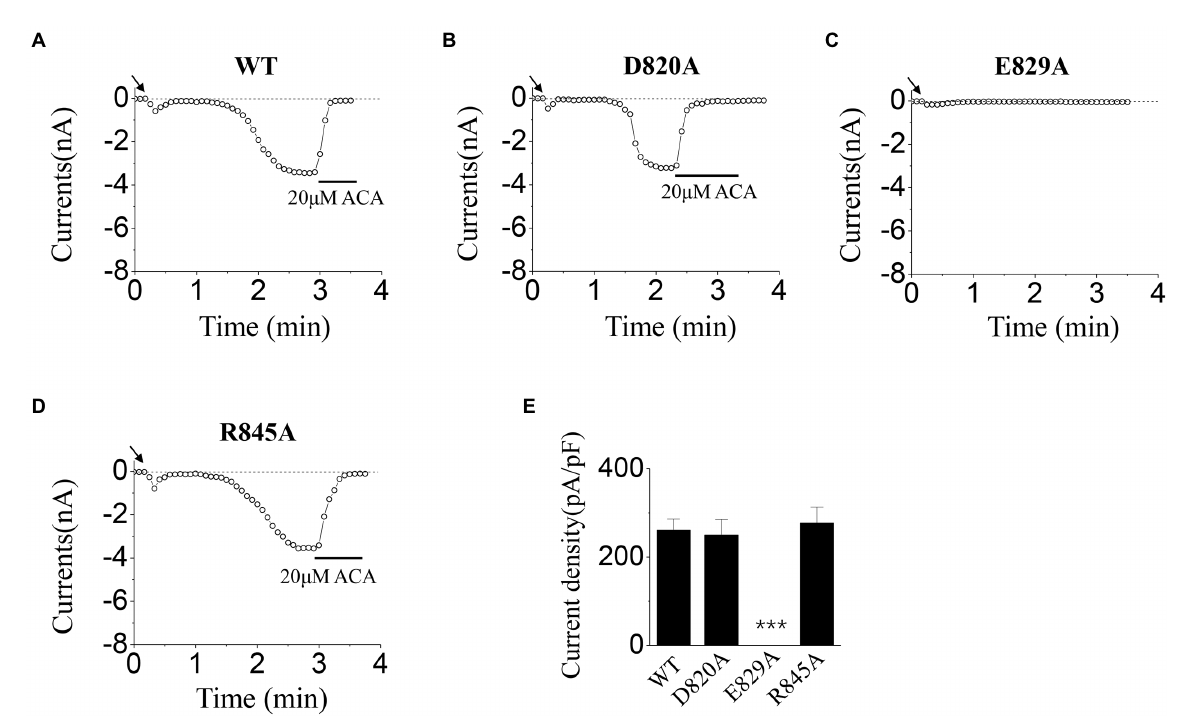
FIGURE 4 Functional assay of WT TRPM2 and its alanine mutants. (A–D) Representative whole-cell recordings of TRPM2 channel currents induced by ICS of 50 mM Ca 2+ from HEK293T cells expressing (A) WT, (B) D820A, (C) E829A, and (D) R845A. The arrow in each panel indicates the time point at which whole cell configuration was established. (E) Summary of the current density induced in cells expressing WT and the mutants. In each case, six cells were tested. *** p < 0.001 compared with